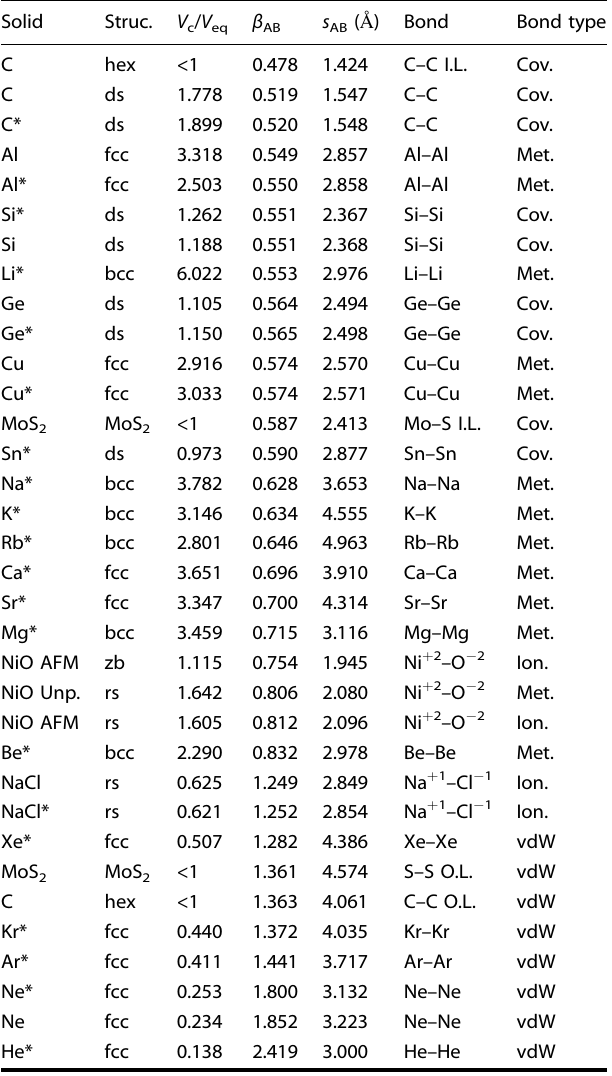
Table 1. Chemical bonding properties from atomic turning surface